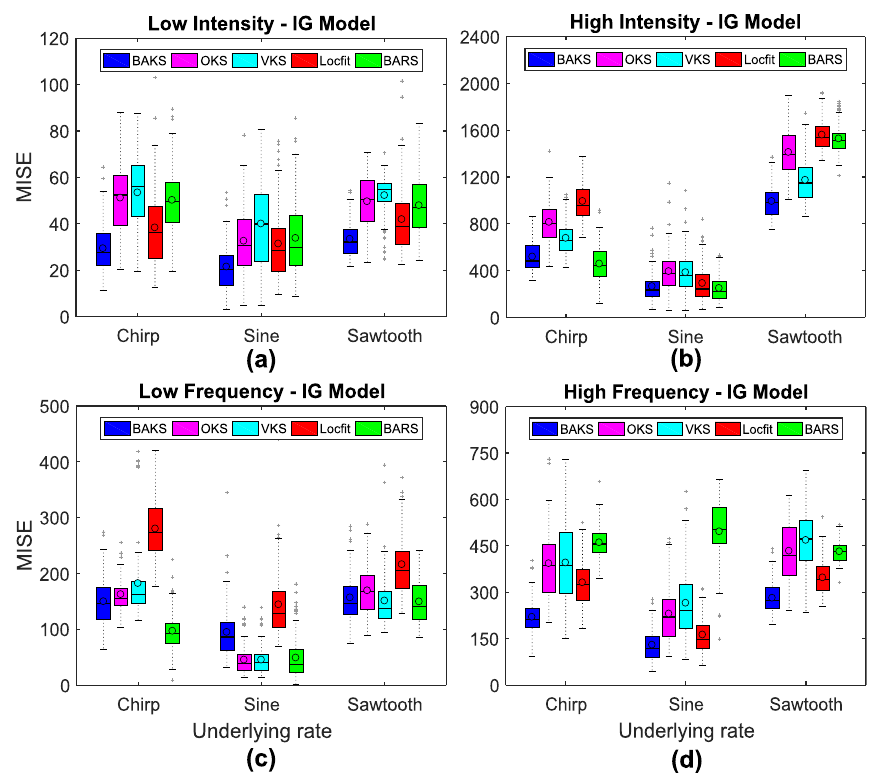
Fig 6. MISE comparison under different values of intensity and frequency for IG model. (a) MISE comparison for the case of low intensity. (b) MISE comparison for the case of high intensity. (c) MISE comparison for the case of low frequency. (d) MISE comparison for the case of high frequency. In each boxplot, black lines show the medians; black circles indicate the means; colored solid boxes represent interquartile ranges; whiskers extend 1.5 × from upper and lower quartiles; gray crosses represent